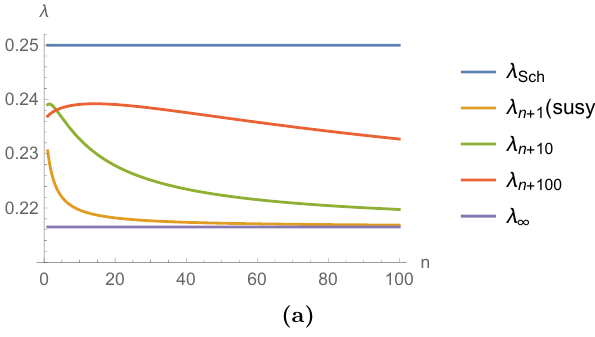
Figure 5. Lyapunov exponents of different JMaRT solutions including the GMS limit m = n + 1 and its n → ∞ limit. We plot in blue the 5-dimensional Schwarzschild BH Lyapunov